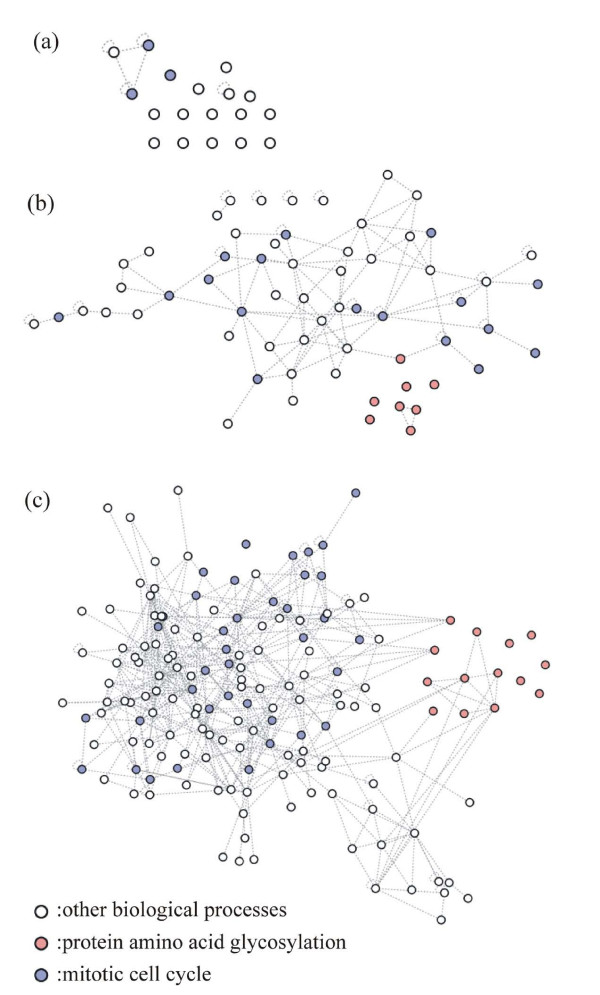
The visualization of known physical or genetic interactions from the BioGRID database [25] for (a) 11th cluster (cutoff = 0.7), (b) 1st cluster (cutoff = 0.6), and (b) 2nd cluster (cutoff = 0.5). The nodes are labeled with color according to three GO terms of biological process: mitotic cell cycle process, protein amino acid glycosylation, and other biological processes.